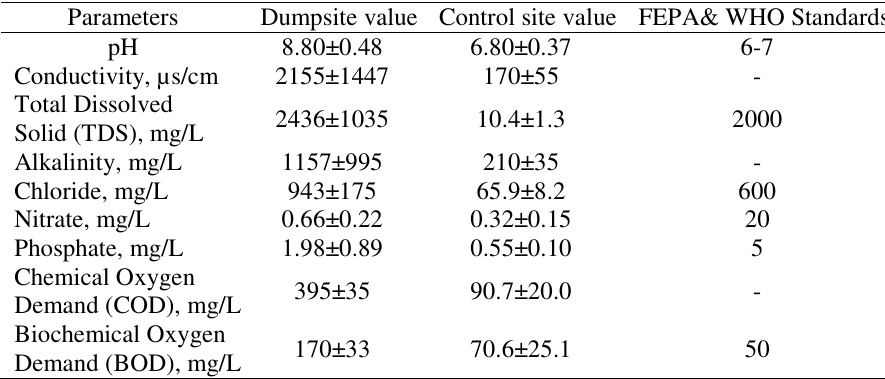
Table 1. Physico chemical characteristics of leachates from Aperin dumpsite and control site